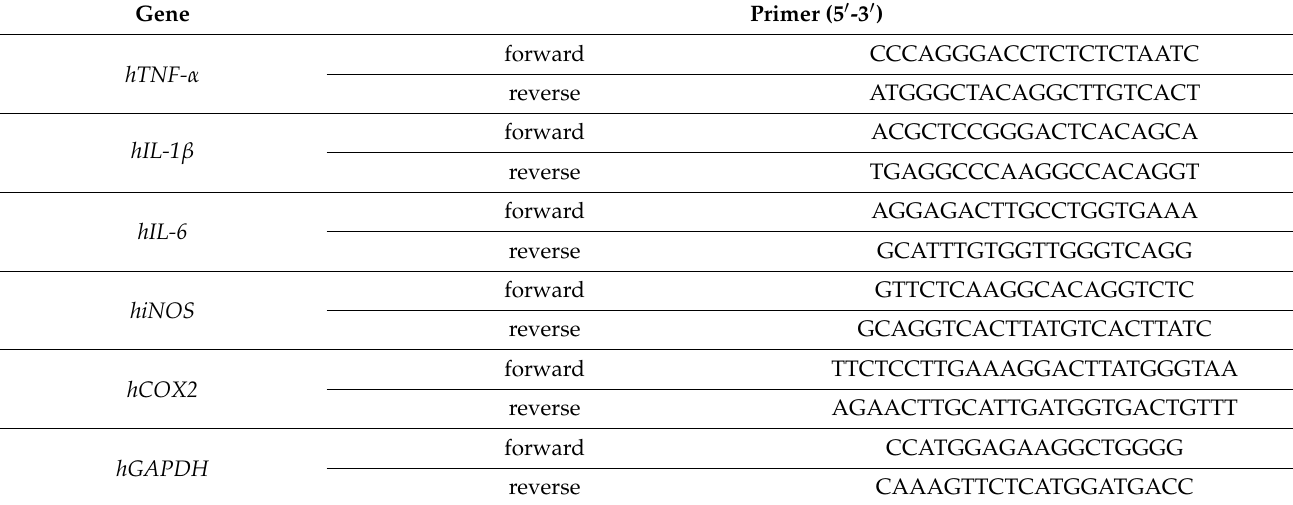
Table 1. Nucleotide sequences of real-time PCR